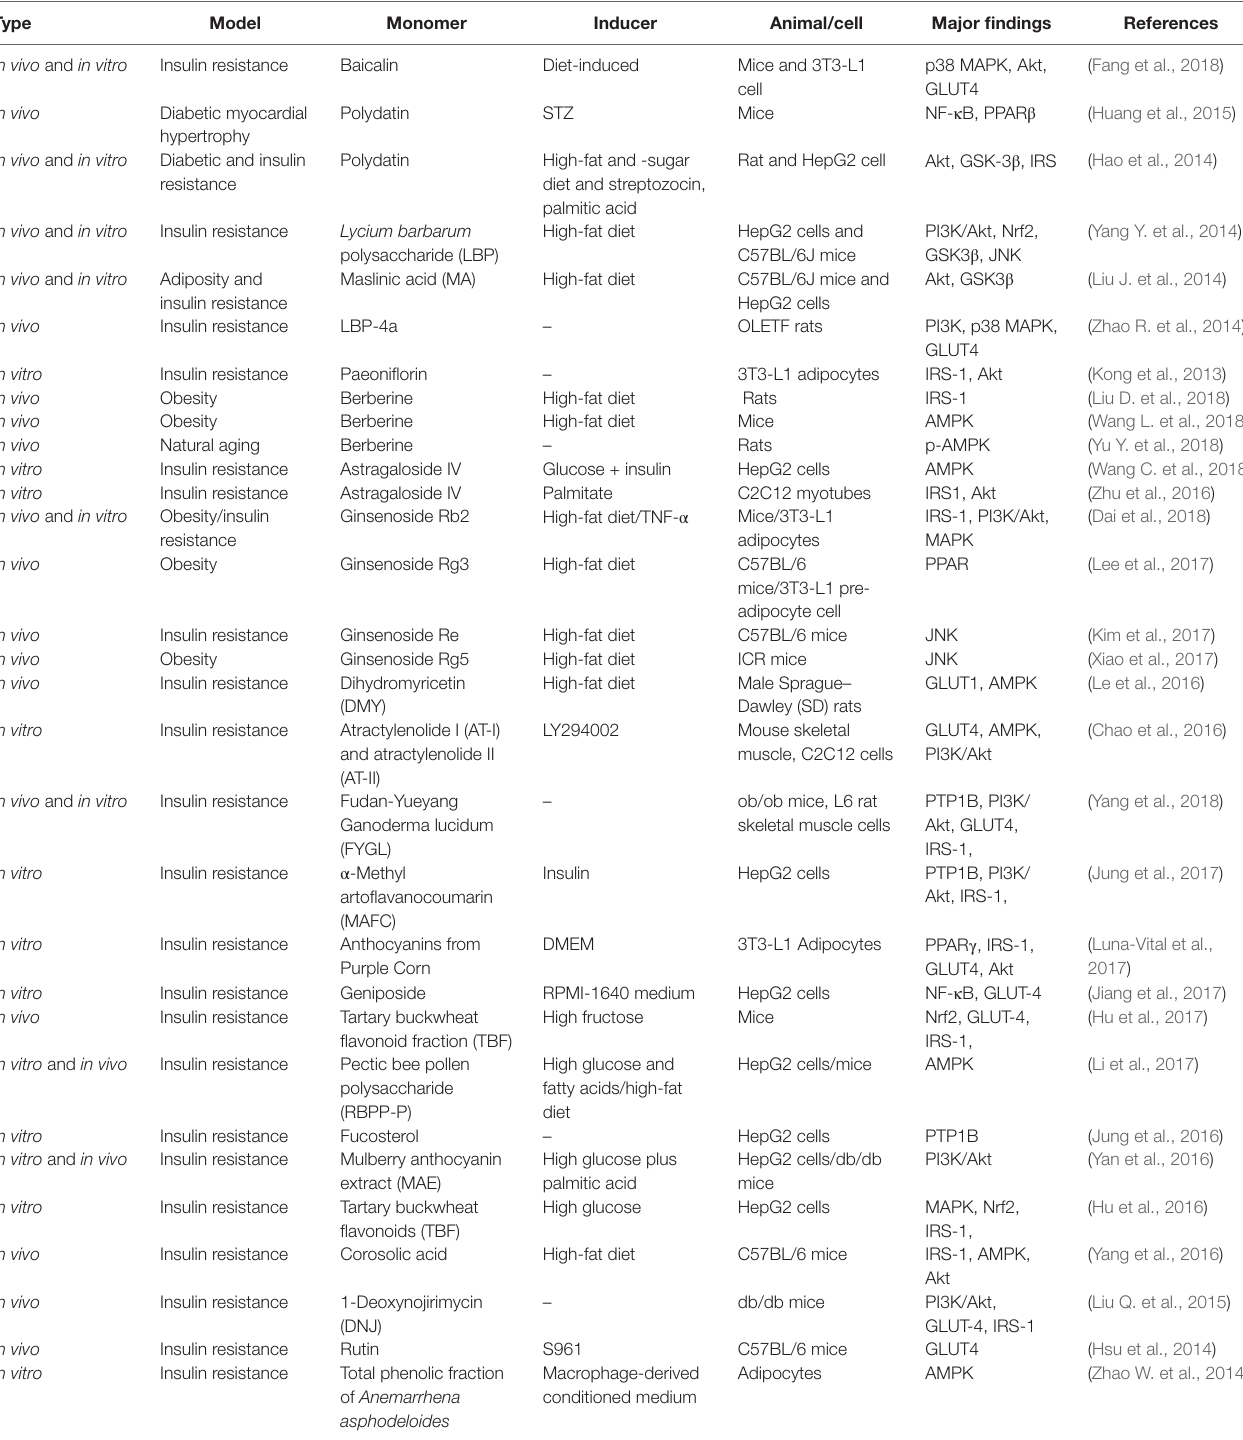
TABLE 4 | Active ingredients for improving insulin